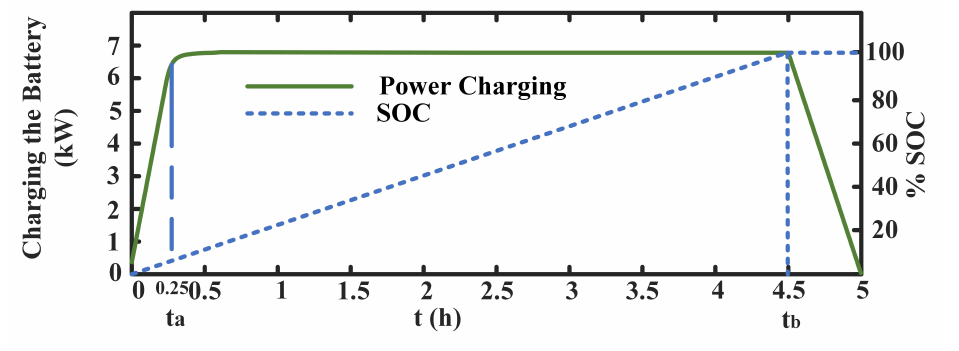
Figure 7. Li-ion battery charging